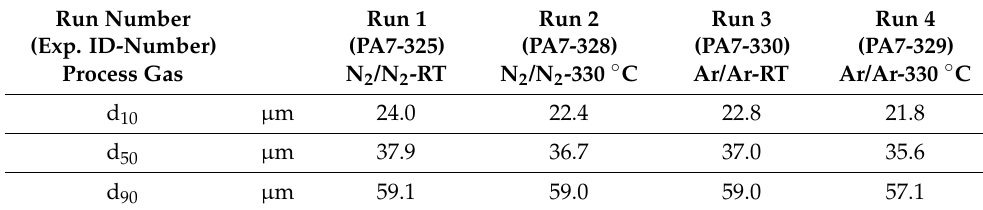
Table 6. Particle size parameters of the powder fraction 20–63 µ